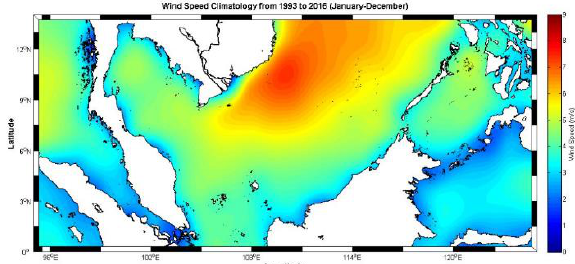
Figure 12. Average wind speed of twelve months for 24 years period 1993 to 2016